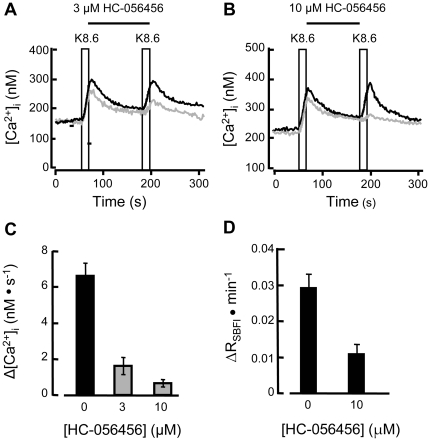
HC-056456 blocks alkaline KCl-evoked increases in [Ca2+]i and [Na+]i.(A,B) Intracellular [Ca2+] for sperm perfused with HS alone (black traces) except during two 10 s stimuli with medium K8.6 (boxed). In a similar protocol using fresh sperm from the same animal, the inter-pulse medium HS also contained 3 or 10 µM of HC-056456 (gray traces). In (A) the HC-056456 also was present in the K8.6 medium used for the second stimulus. (16–19 groups of cells in 3 independent experiments). (C) Averaged rates of rise for [Ca2+]i during the second stimulus. (D) Intracellular [Na+]i was monitored for cell clusters before and during a 60 s stimulus with Ca2+-deficient HS medium as in Fig. 2. Parallel experiments were conducted with or without 10 µM HC-056456 present in all perfusing media. Averaged rate of change ΔRSBFI was calculated as for Fig. 2 (13–14 groups of cells in 3 independent experiments).